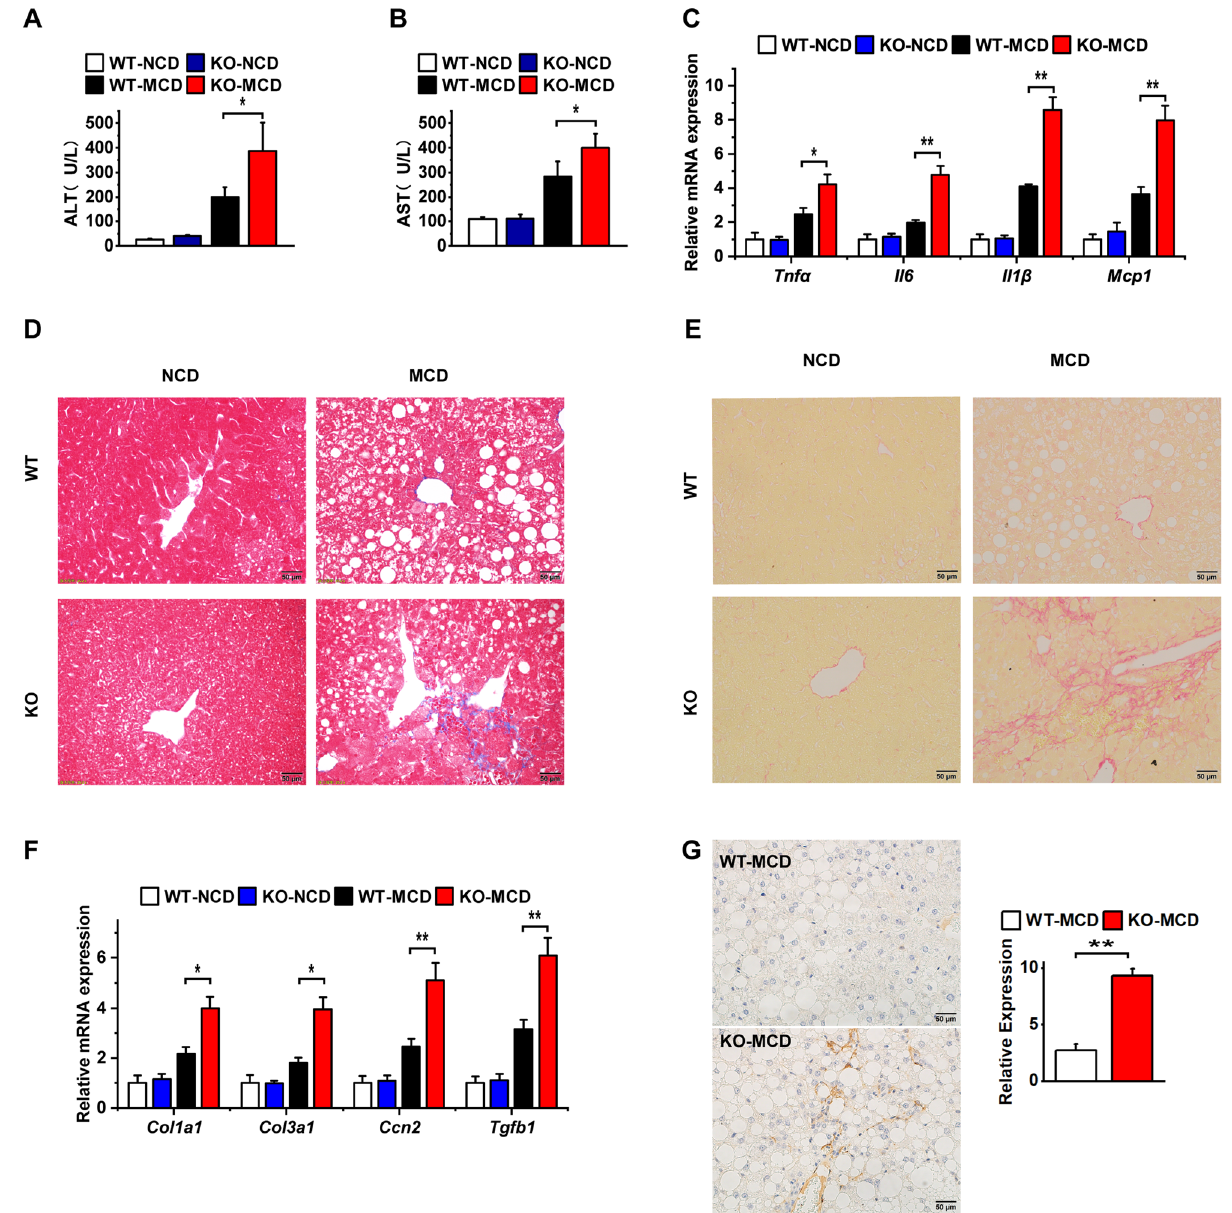
Figure 4. Osteoprotegerin (OPG) deficiency exacerbated methionine- and choline-deficient (MCD) diet- induced liver injury. ( A ) Serum alanine aminotransferase levels. ( B ) Serum aspartate aminotransferase levels. ( C ) Inflammatory gene expression. ( D ) The representative image of Masson staining. ( E ) The representative image of Sirius red dye. ( F ) Fibrosis gene expression. ( G ) αSMA immunohistochemical assay. The scale bar is 50 µm. Graph showing comparisons of αSMA expression in liver tissues from MCD diet-induced WT or OPG KO mice. Each group at least has 3 samples. The data in ( A – C ), ( F , G ) are presented as the mean ± SD, *p < 0.05; **p <